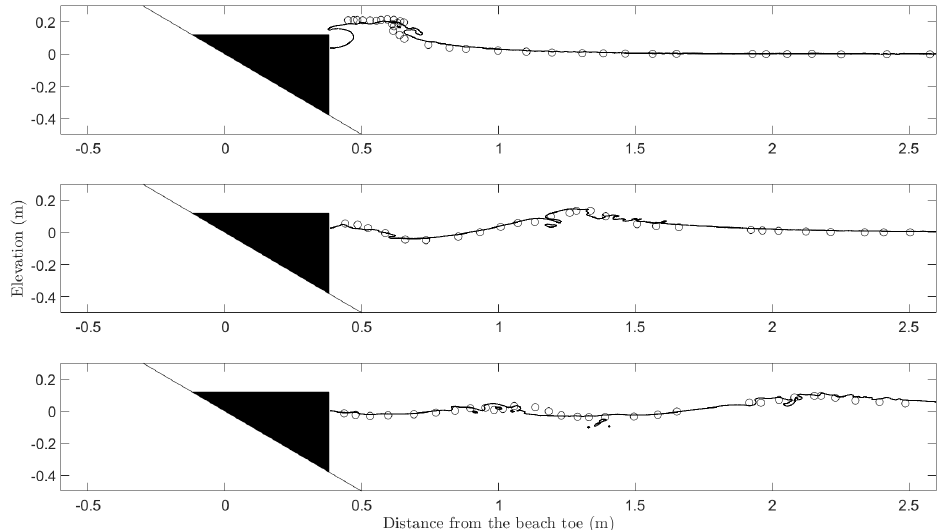
Figure 2. Model validation for subaerial landslide generated waves: snapshots of free-surface profile at select time instants (Top to bottom: t = 0.6,1.0,1.5 s). Dot: model predictions. Circle: measurements reported by Heinrich [51].